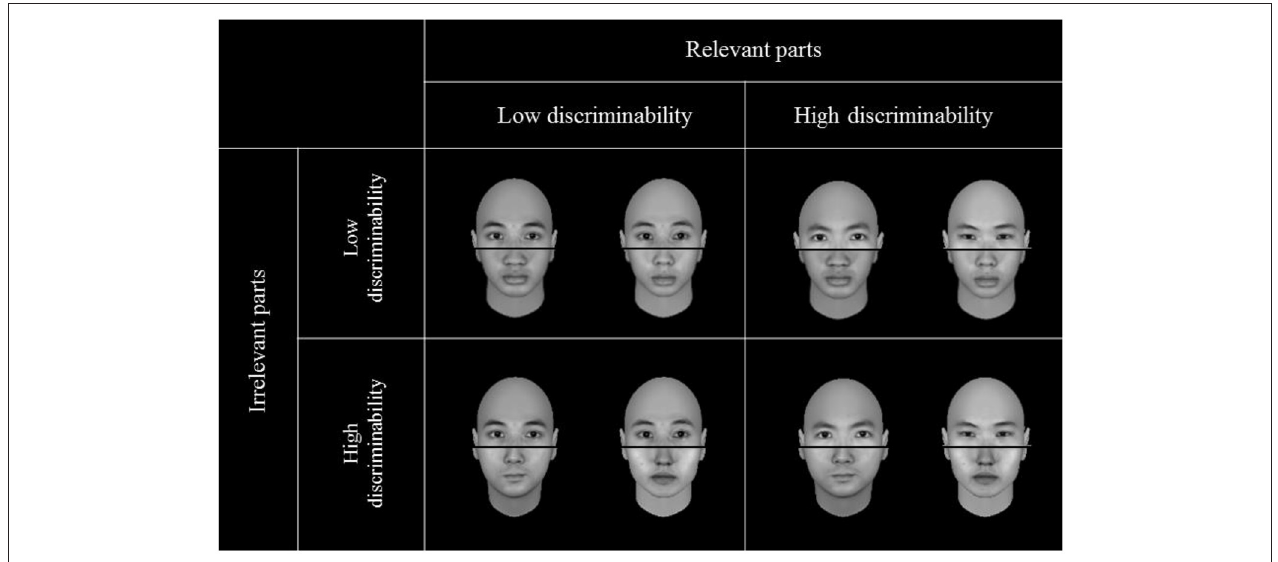
FIGURE 3 | The stimuli include high and low perceptual discriminabilities for relevant and irrelevant parts used in both experiments. Note: the relevant part (or target) always refers to the top half and irrelevant part refers to the bottom half. All the relevant halves and irrelevant halves within a pair were not exactly identical, but the relevant halves on the top two panels were the same as those on the bottom two panels.